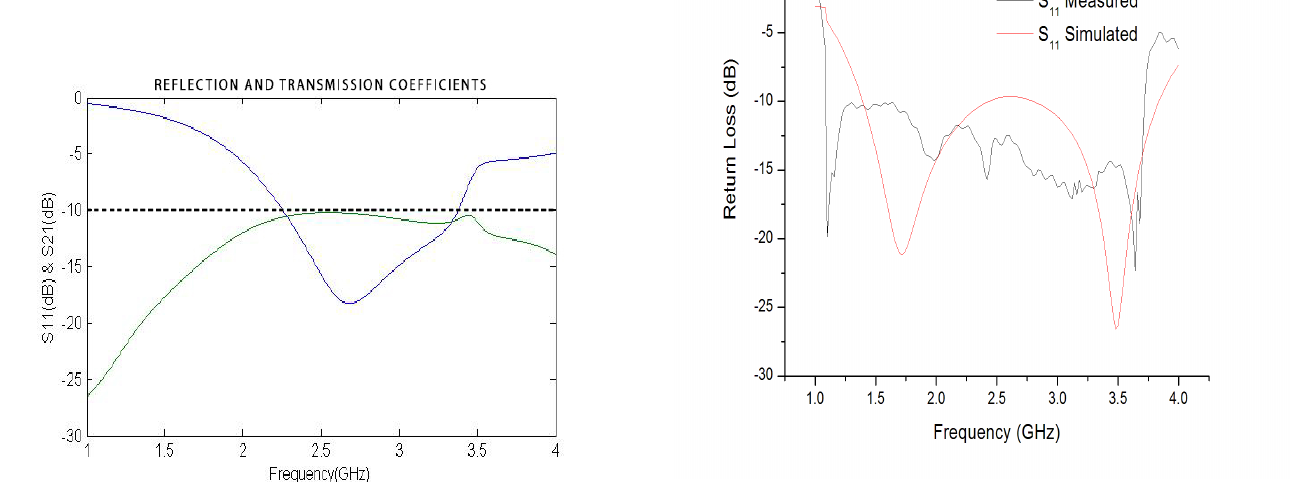
Figure 6: Comparison of simulated and measured Return Loss